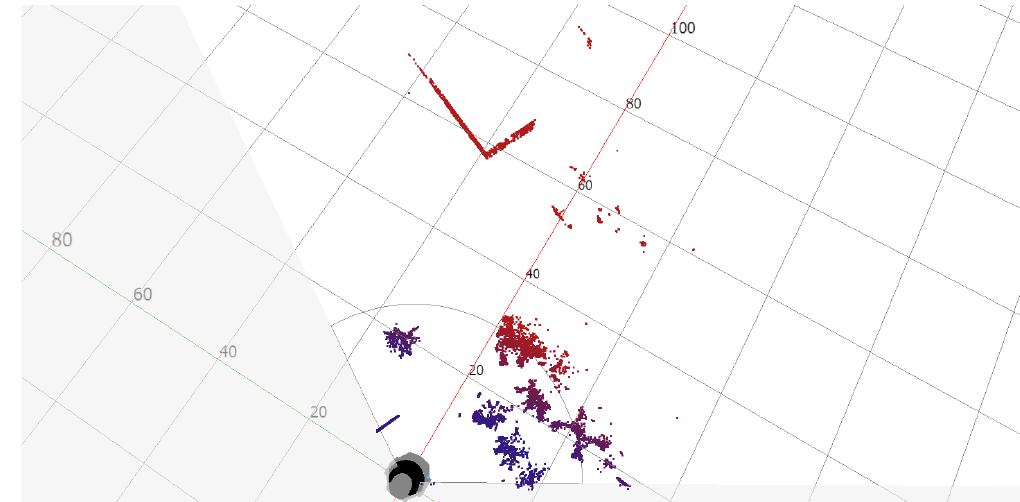
Figure 18. Google Maps view of the Test Area 1 with the marked distance.